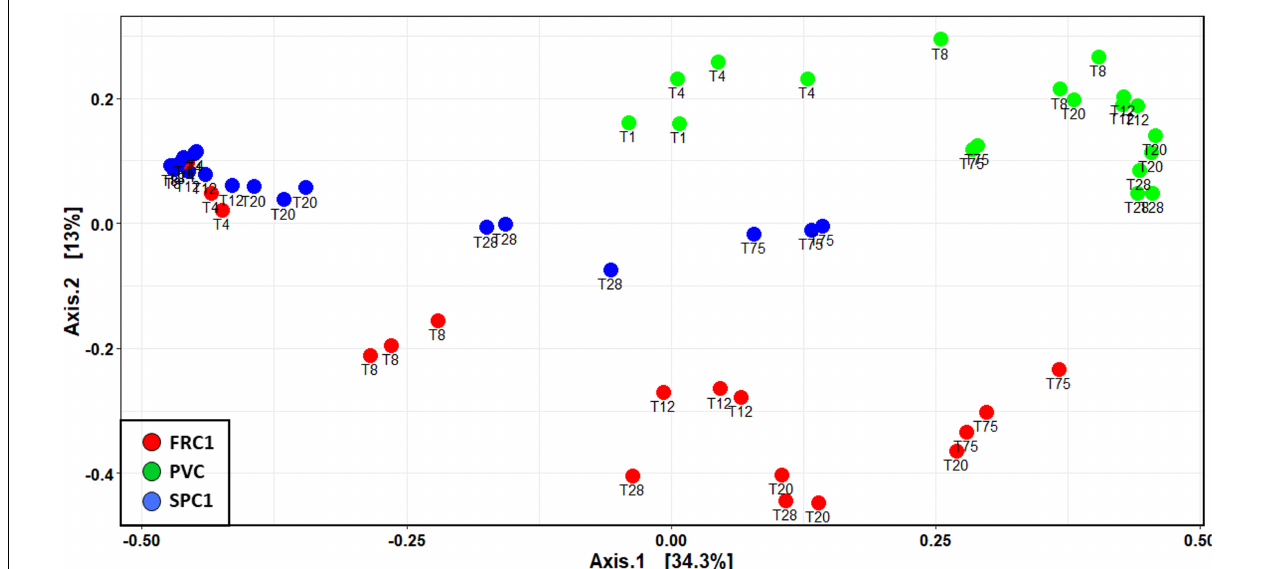
FIGURE 3 | NMDS showing dynamics of prokaryotic communities at Toulon from 1 to 75 days on the three substrates in triplicates (PVC and the two AF coatings, SPC and FRC) based on Bray and Curtis dissimilarity (Kruskal stress =